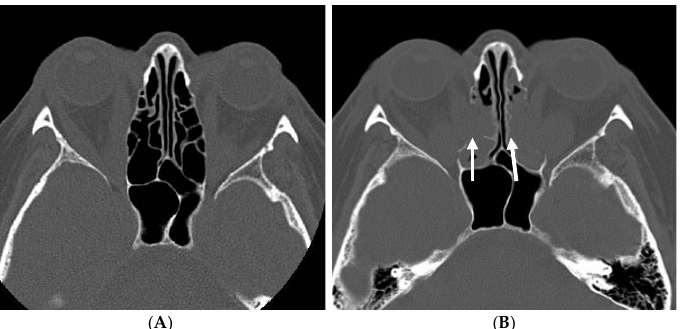
Figure 1. Axial CT scans showing orbital fat protruding into paranasal sinuses. Status before ( A ) and after ( B ) decompression. The fatty tissue filling the nasal cavity is visible (arrows).